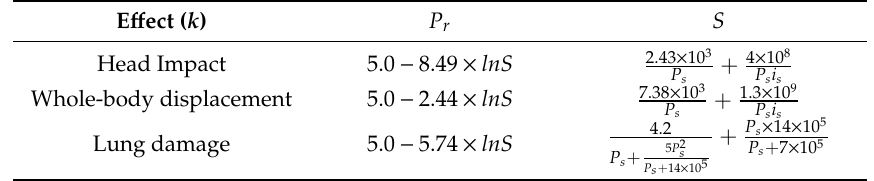
Table 2. S and P r functions with coe ffi cients for all e ff ects ( k )